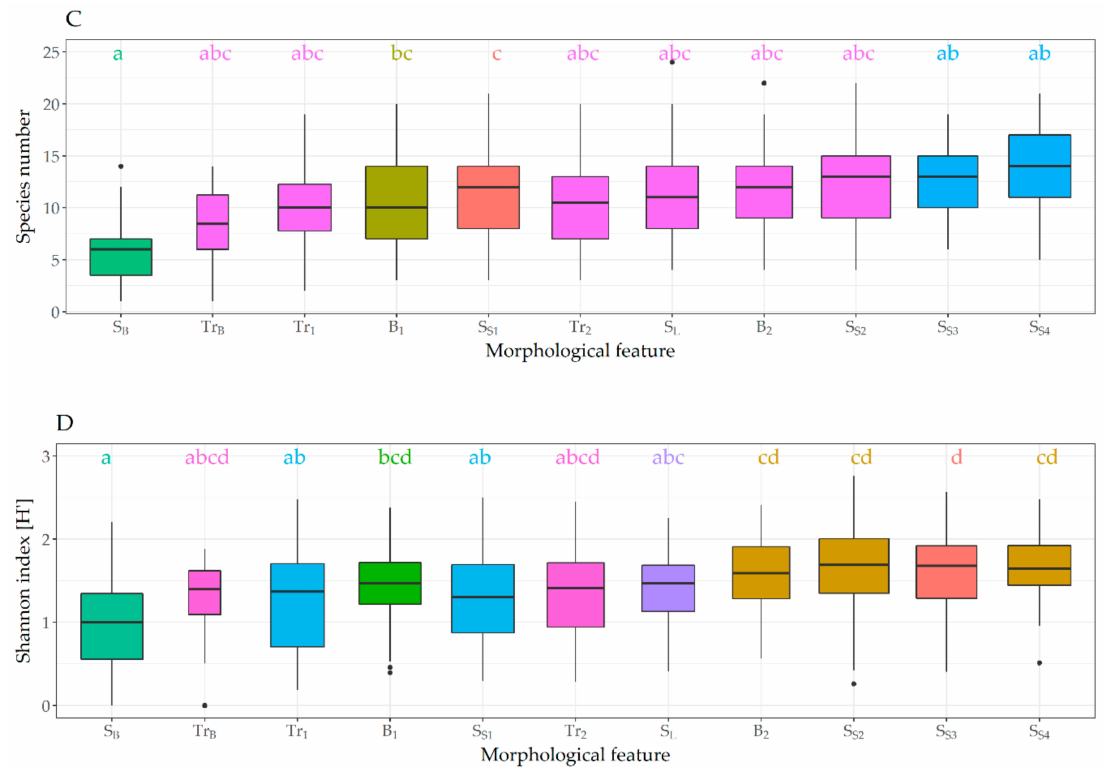
Figure 6. Species abundance ( A ), biomass ( B ), number of species ( C ), and Shannon diversity ( D ) for each morphological feature. The letters at the top and the colors represent the groups resulting from the post-hoc comparison. Morphological features with equal letters show much resemblance. The letter combinations indicate if the morphological feature is standalone or a gradient with elements from other morphological features. Note that the distance between the morphological features on the x -axis is not to